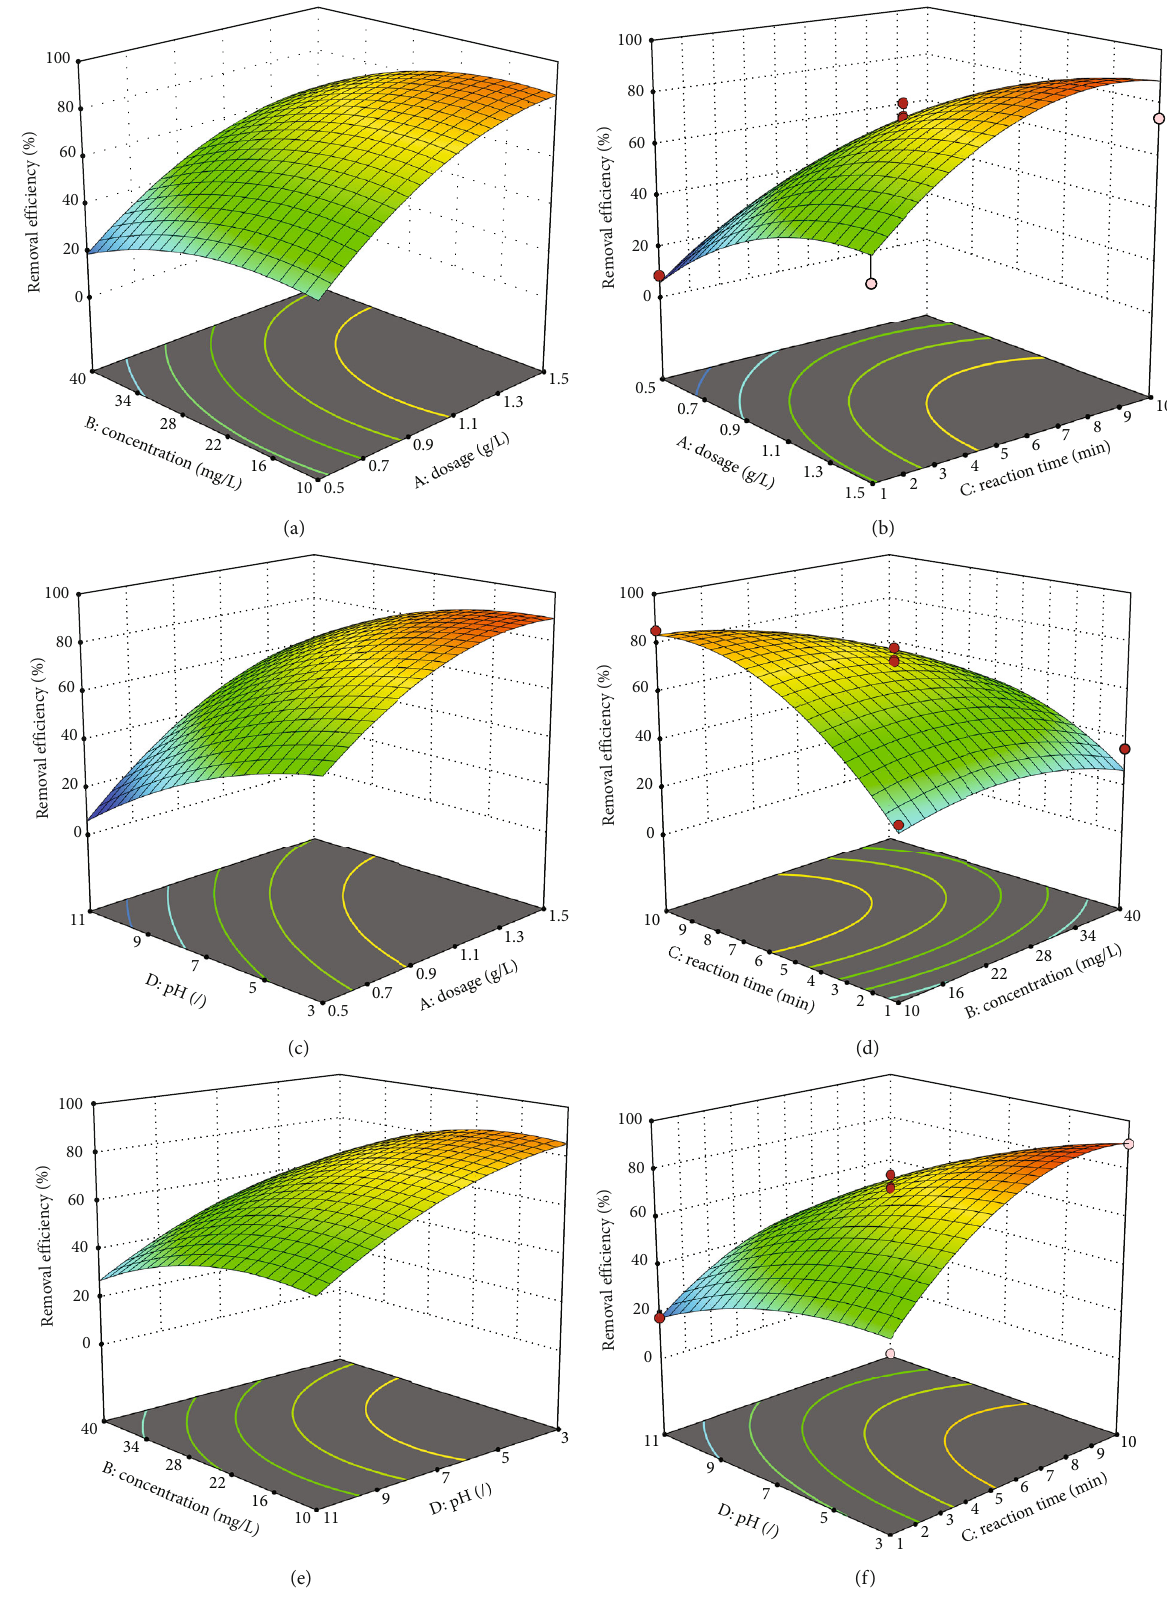
Figure 7: The 3D response surface plots for the (a) dosage and initial concentration, (b) dosage and reaction time, (c) initial pH and dosage, (d) initial concentration and reaction time, (e) initial concentration and initial pH, and (f) initial pH and reaction